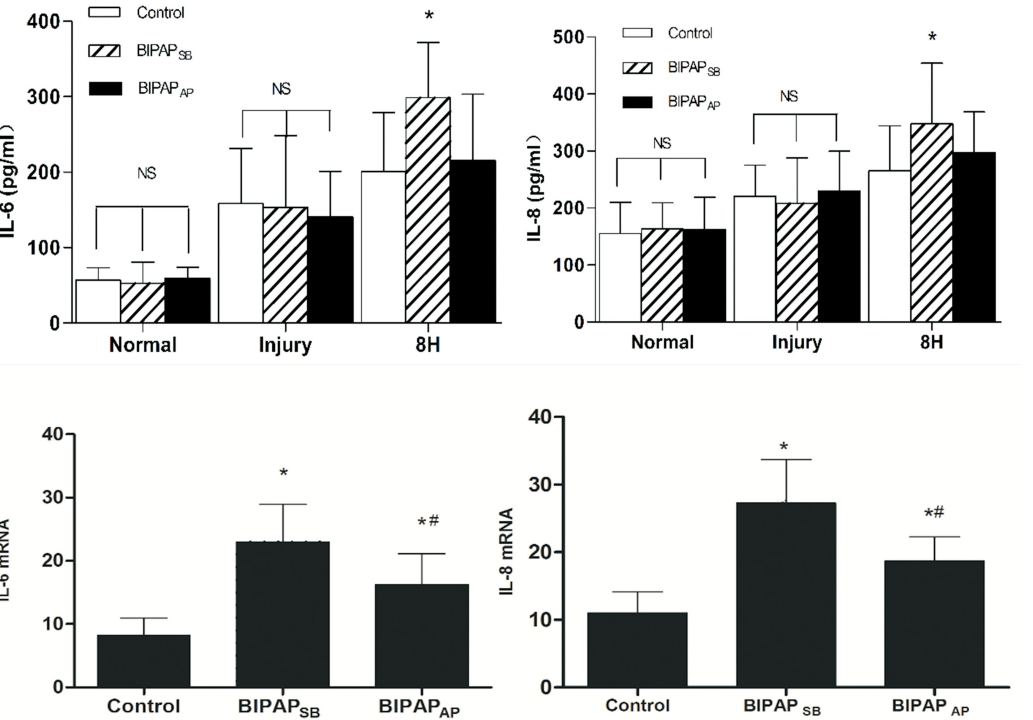
vs. control group; #P < 0.05 vs. BIPAP AP group;). BIPAP SB = biphasic positive airway pressure with SB, n = 6; BIPAP AP = biphasic positive airway pressure with abdominal muscles paralysis, n = 6; SB = spontaneous breathing; NS = no significantly difference;